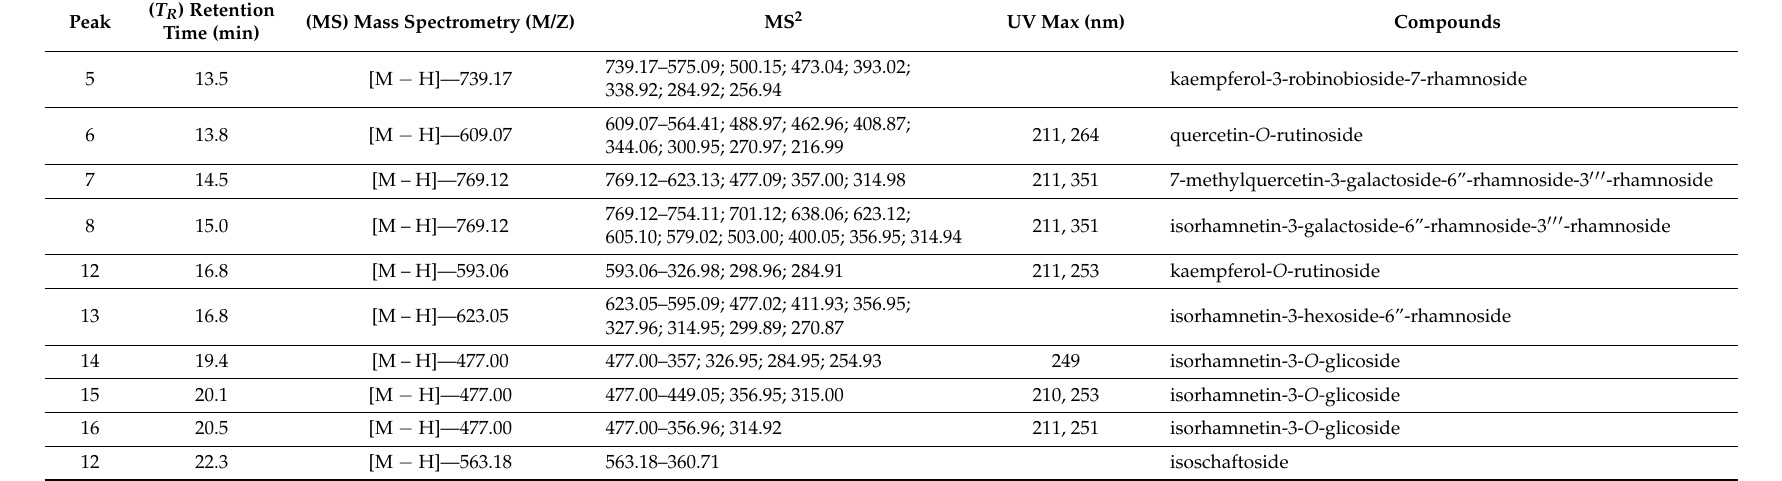
Table 1. Flavonoids identified by HPLC–HRESI-MS in the hydroethanolic extract of T. catharinensis leaves.